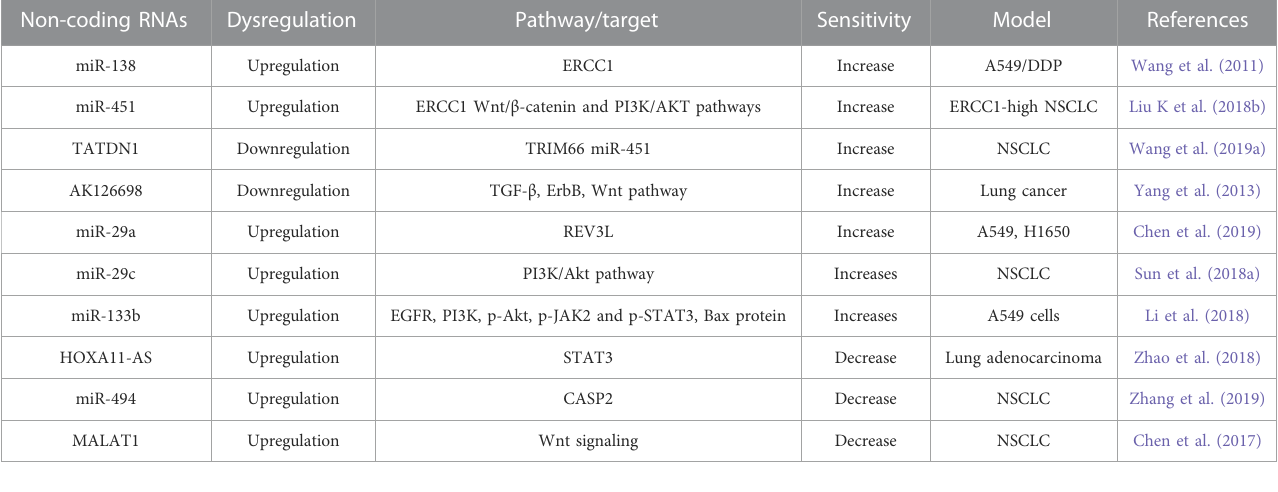
TABLE 2 Role of Non-coding RNAs on the regulation of signaling pathways involved in cisplatin-resistance.